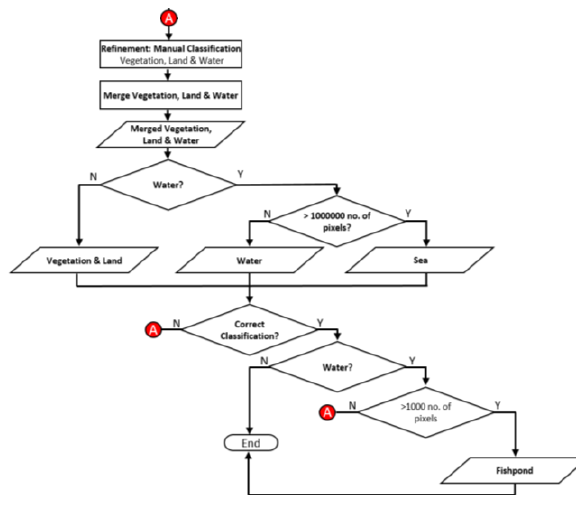
Figure 1b. Detailed workflow of Aquaculture ponds (fishpond) feature extraction.